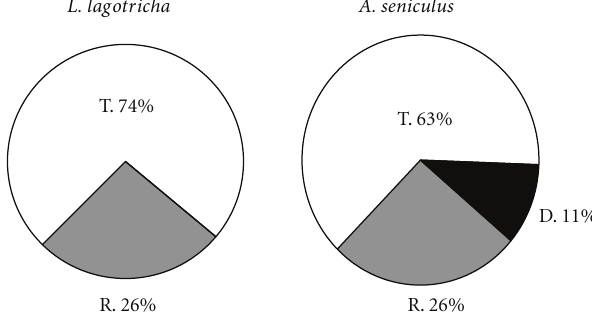
Figure 2: Richness of the three relocating guilds (R: rollers, T: tunnelers, D: dwellers) in the two dung types ( L. lagotricha and A. seniculus ) in the area, CIEM-Meta,